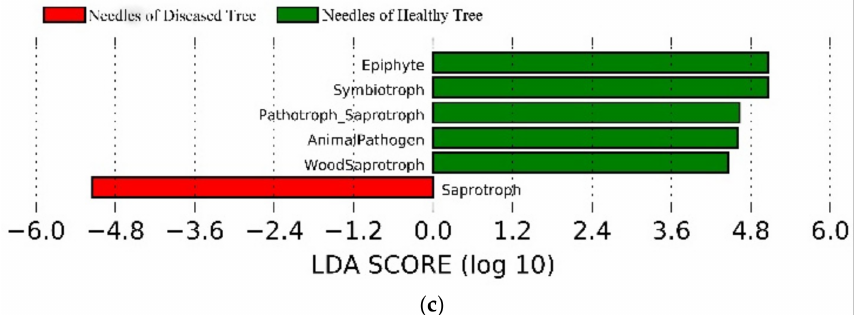
Figure 7. LEfSe (LDA > 2.0, p < 0.05) showing predicted functional groups significantly presented in ( a ) soil, ( b ) roots, and ( c ) needles around and of healthy and diseased samples. Similar to community structure, CCA showed that the fungal functional structures differed only in the needles of healthy and diseased trees ( p < 0.01), but in neither the soil